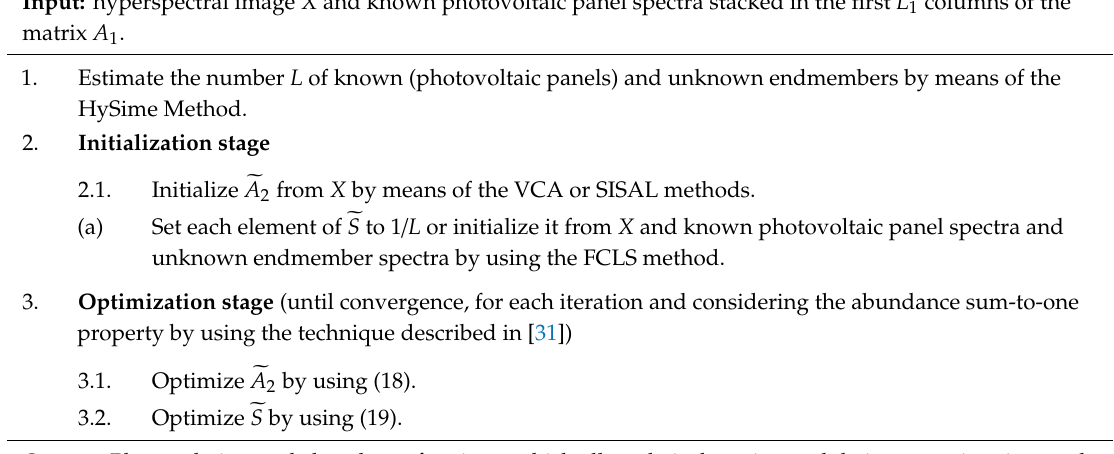
Algorithm 2: Multi-Part-NMF unmixing for automatically detecting photovoltaic panels and estimating their areas in urban hyperspectral remote sensing